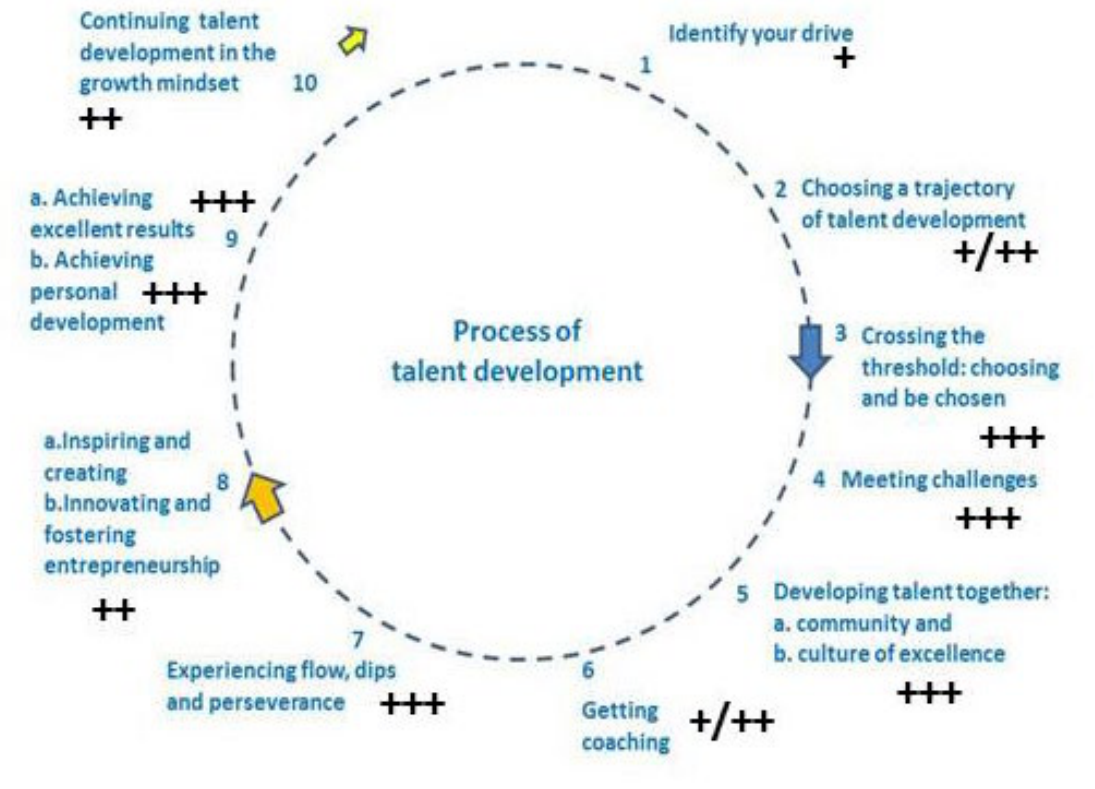
Figure 1. Circle of Talent Development in relation with the good practice ‘Writing a book’ with the teacher’s